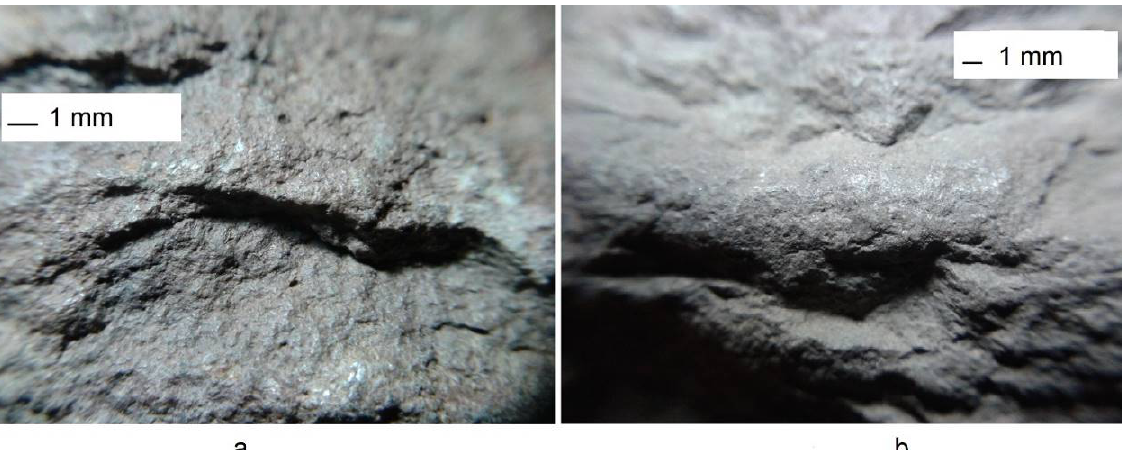
Figure 10. (a) Specimen 3, an individual step-fracture removal scar on a working edge. (b) Specimen 12, rounding and light polish on a step-fracture scar ridge. (Photographs by Steve Tomka.)